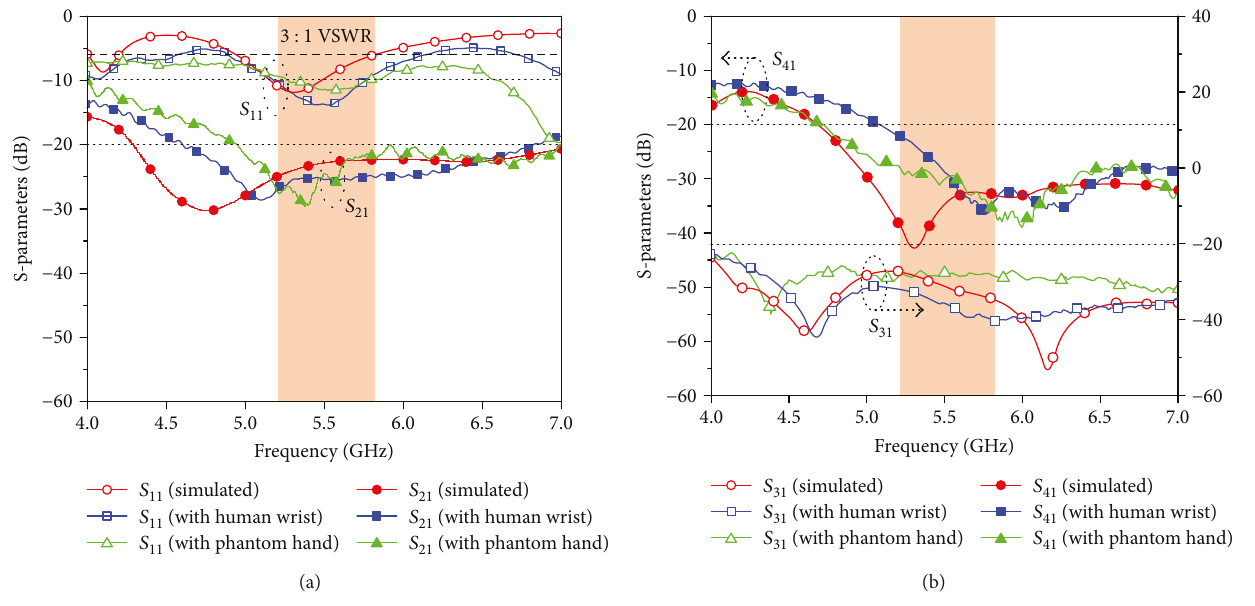
Figure 13: Comparison of the S-parameters obtained when simulation is conducted by using a wrist model, measurement is conducted by using a phantom hand, and measurement is conducted by using a human wrist: (a) S 11 and S 21 and (b) S 31 and S